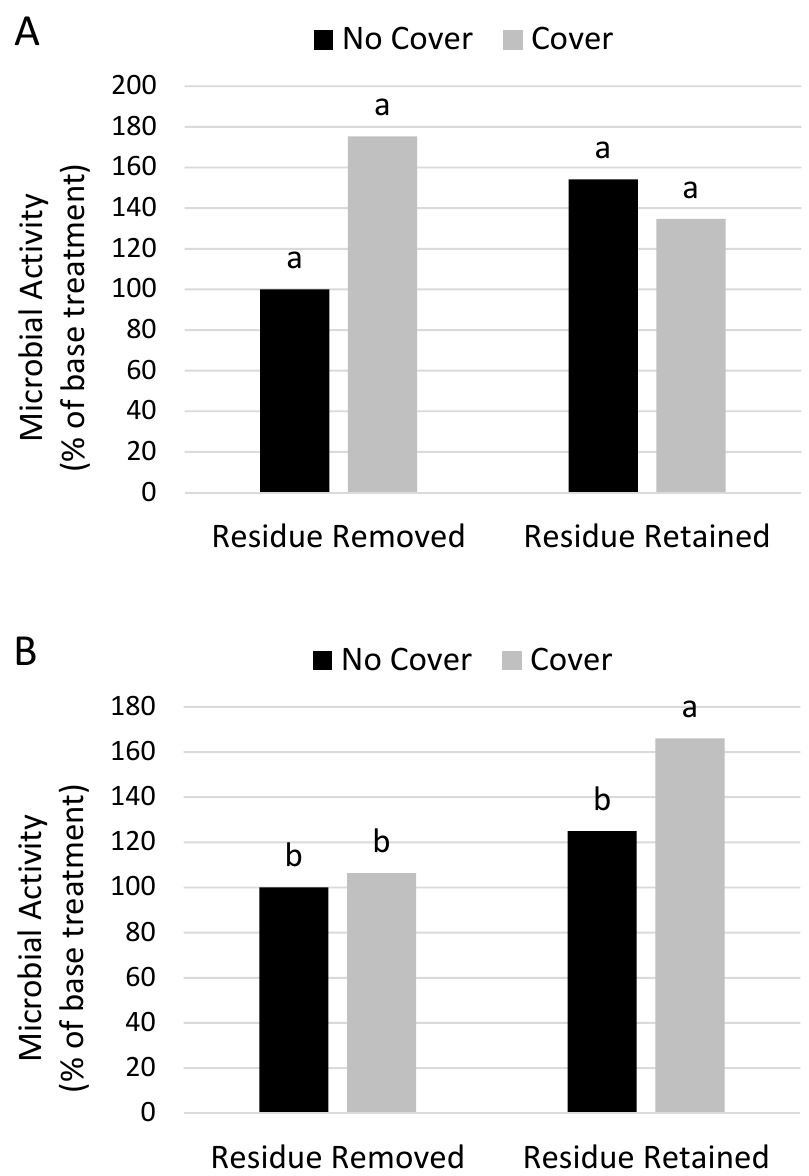
Figure 6. Microbial activity measured by fluorescein diacetate (FDA) hydrolysis in the 0–5 cm depth interval values are means ( n = 3) for each treatment expressed as percentages of the mean for the default management treatment with corn residue removal and no cover crop. ( A ) Corn phase. ( B ) Soybean phase. Values marked with the same letter within the aggregate group are not different at α = 0.10, Tukey’s test. Values in this graph are calculated from selected data published in [24] and presented with revised statistics for the selected data.